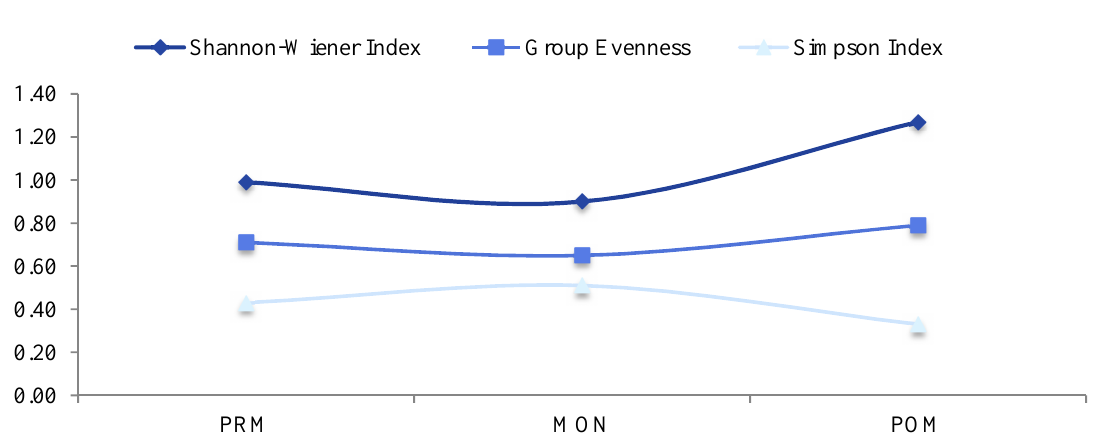
Figure 5. Variations in taxon frequency diversity indices of macroinvertebrates PRM: Premonsoon; MON: Monsoon; POM: